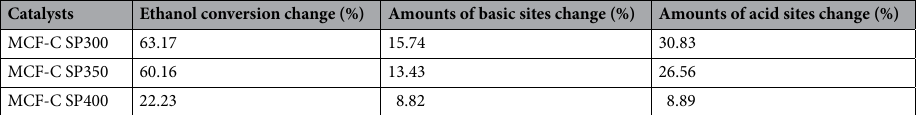
Table 5. The relationship between the catalytic activity and chemical properties as basicity and acidity base on operating time for 12 h.